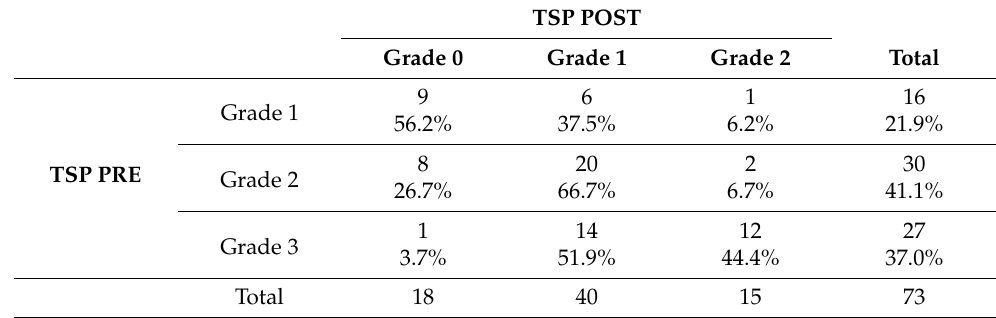
Table 2. Contingency table with number of cases and percentages of TSP classification, preoperatively (PRE) and at follow-up (POST). p < 0.001 in McNemar test. TSP: Tibial sesamoid